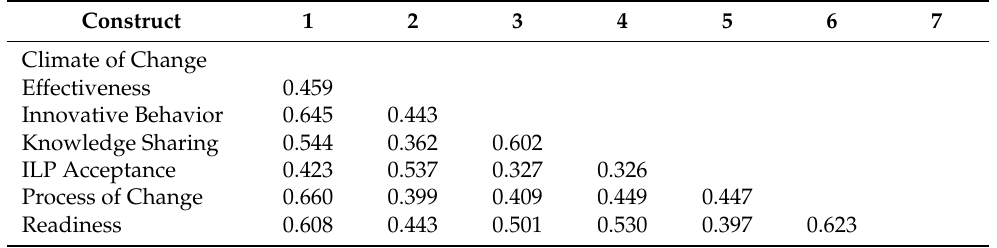
Table 2. Heterotrait-Monotrait ratio of correlations,